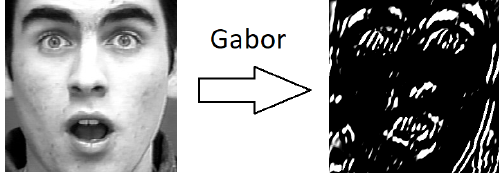
Figure 18. Feature map of Gabor for a face from the CK+